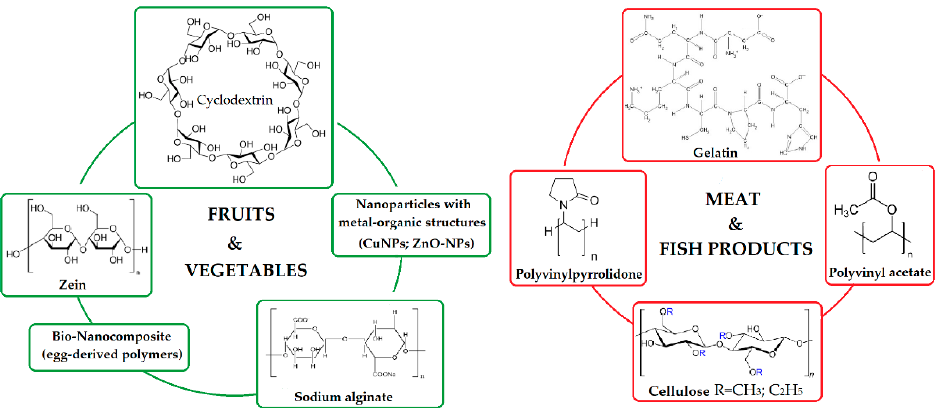
Figure 6. Types of polymers for the conditioning of curcumin used as an additive in the food in- dustry.